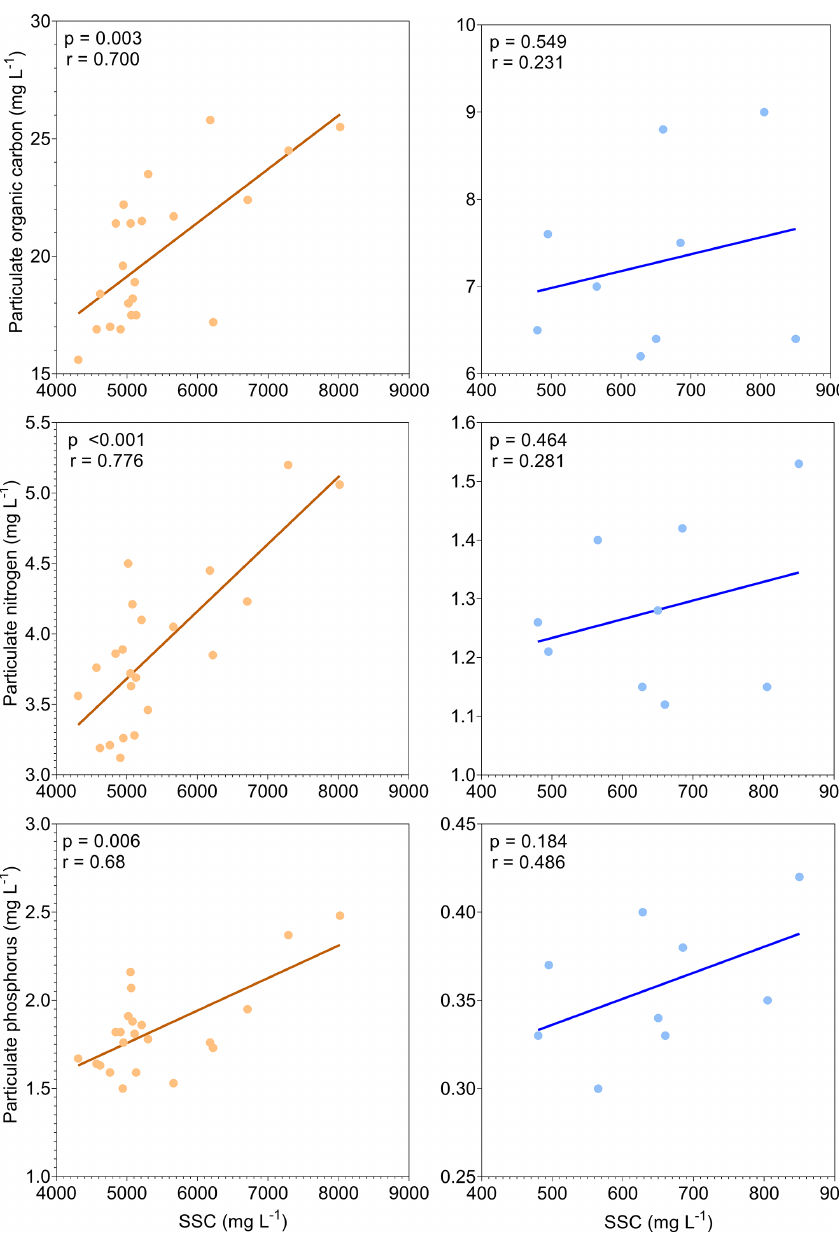
Figure 11. Relationships between SSC and particulate organic carbon and nutrient concentrations in the control (brown) and remediated gully (blue) from single flow events on the same day during 2017–2018 wet